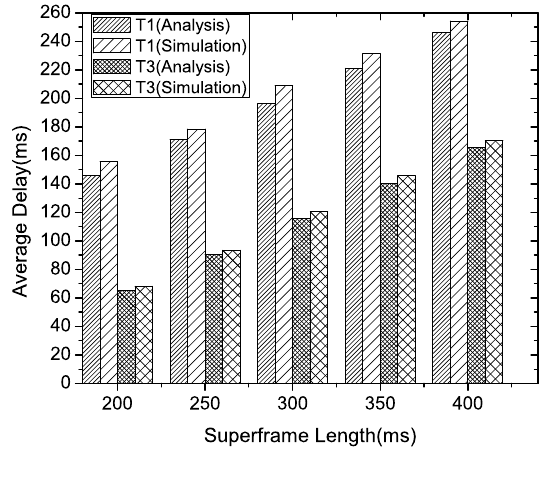
Figure 8. Delay performance comparison of type 1 and type 3 traffic both in analysis and